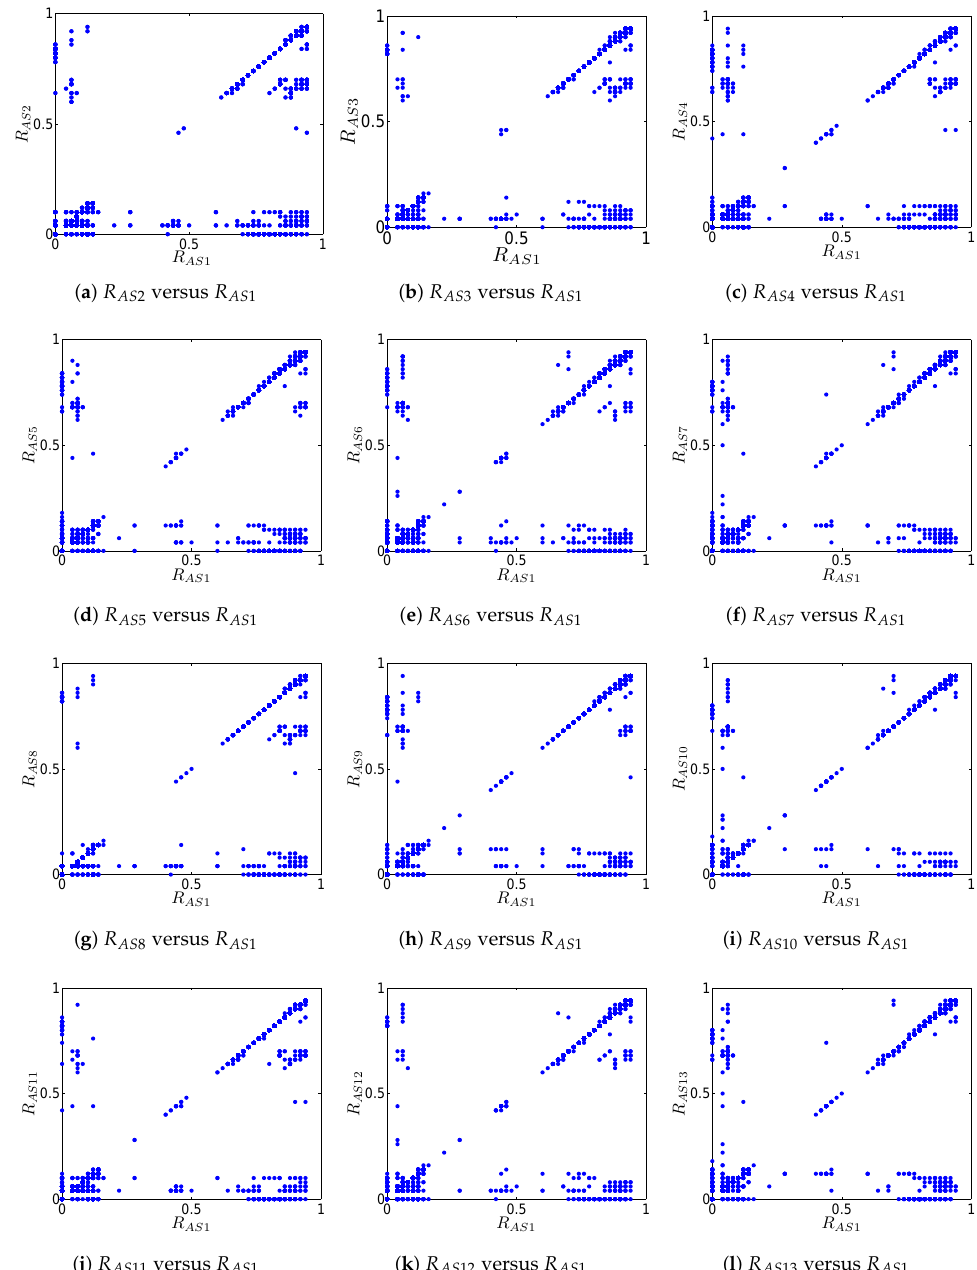
Figure 5. Robustness of an interdependent Cyber-Physical network under different attack sequences with the same target sets. AS1 represents the simultaneous attack. AS2–AS7 represent sequential attacks. AS7–AS13 are composite